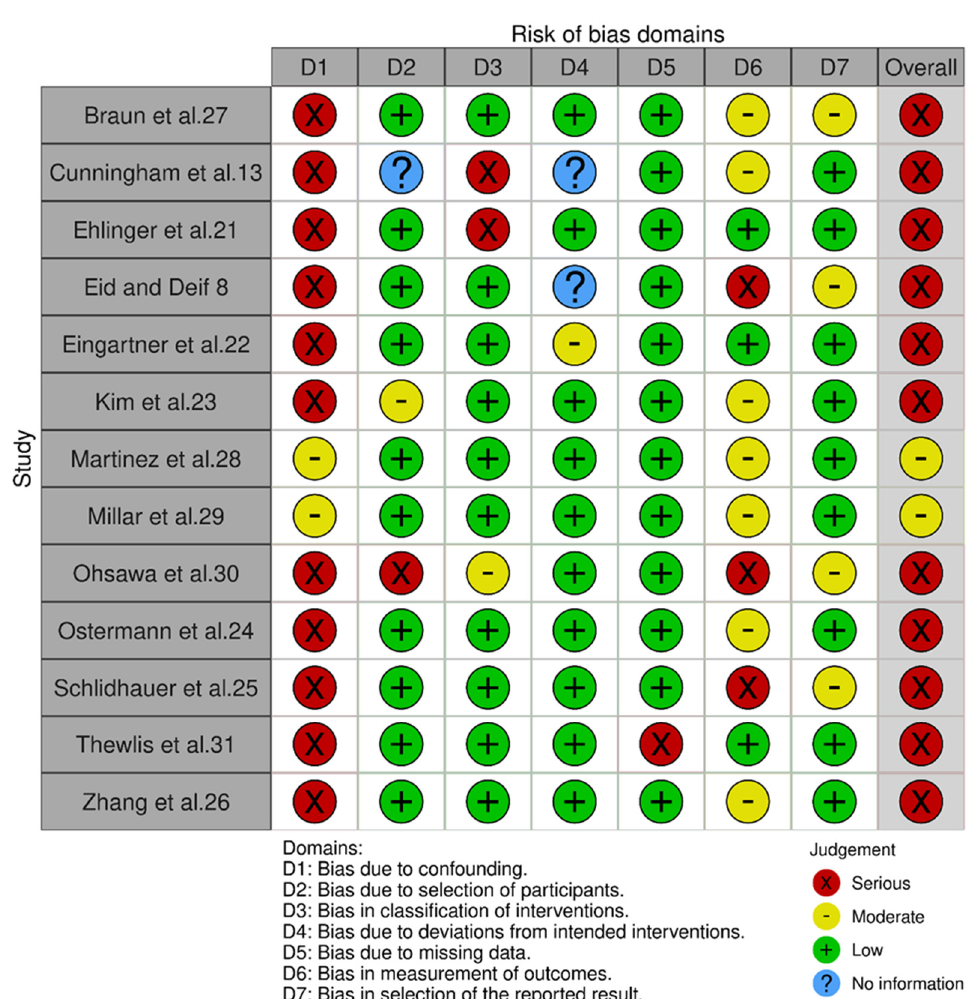
Figure 3. Non-randomized controlled trials risk of bias.